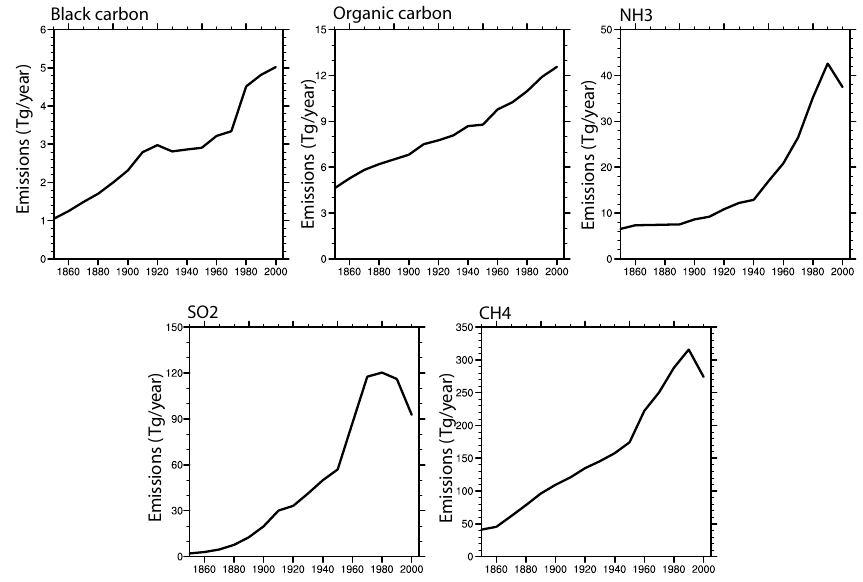
Fig. 2. Time evolution of the total (sum of all sectors) land anthropogenic emissions for black carbon (Tg(C)/year), organic carbon (Tg(C)/year), ammonia (Tg(NH 3 )/year), sulfur dioxide (Tg(SO 2 )/year), and methane (Tg(CH 4 )/year).